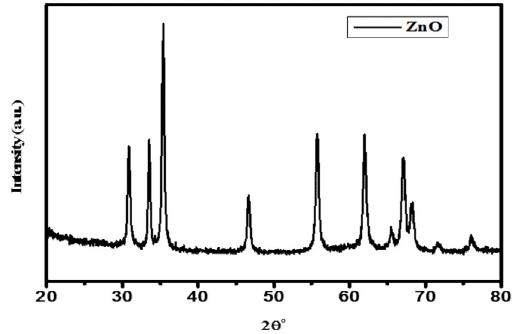
Fig. 2. XRD diagram of ZnO nano catalyst Fig. 2.XRD diagram of ZnO nano catalyst.